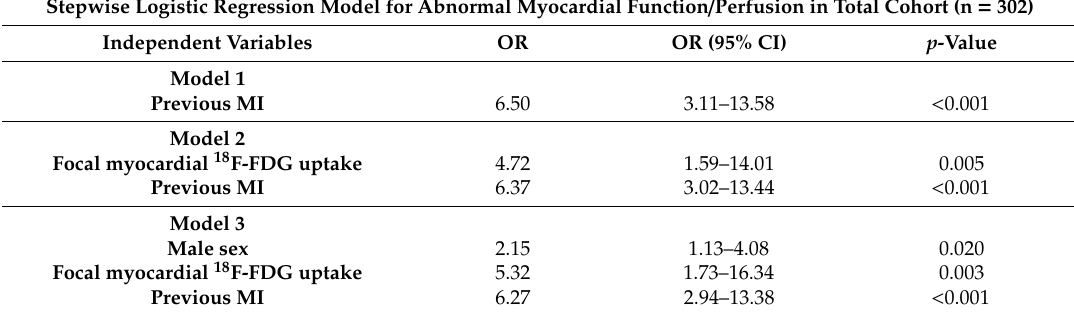
Table 3. Predictive value of 18 F-FDG myocardial uptake pattern for abnormal MPI findings. Stepwise Logistic Regression Model for Abnormal Myocardial Function / Perfusion in Total Cohort (n = 302)